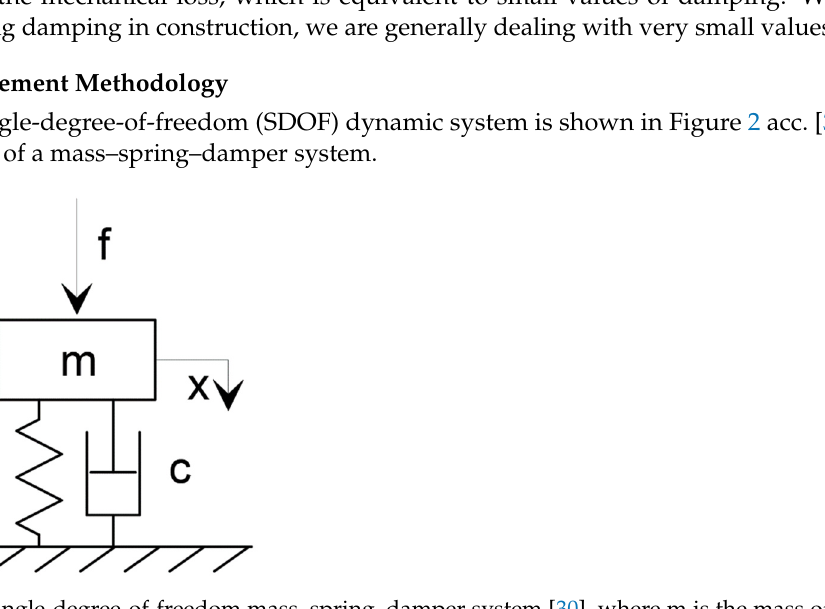
Table 2. Detailed characteristics of key components of dynamic stiffness machine.